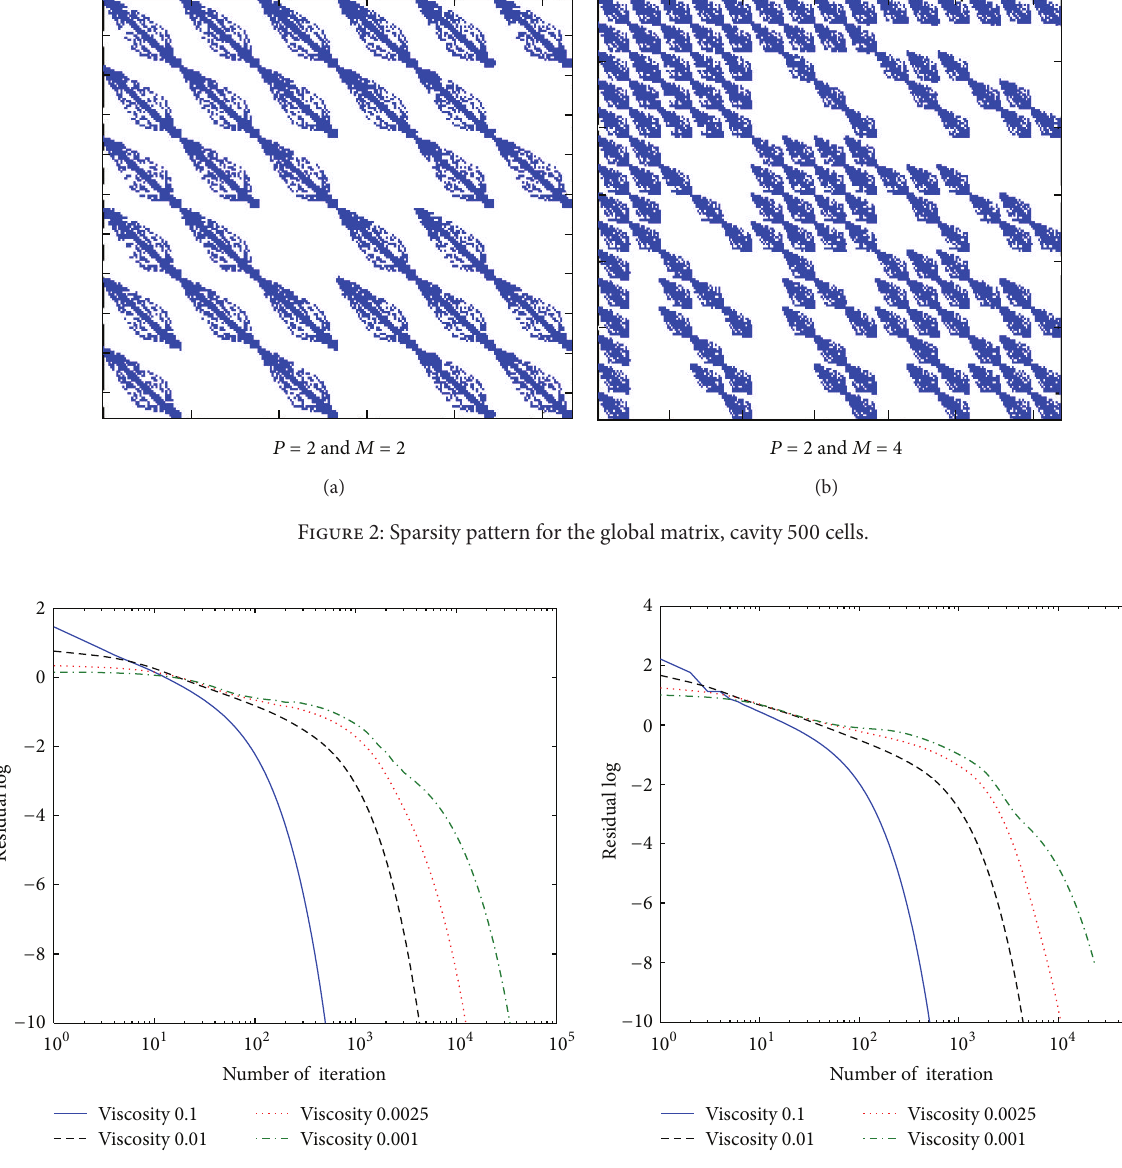
cost will be 𝑂(𝑁𝑀 𝑃 ) , where 𝑁 is the number of degrees of freedom (number of nonboundary nodes in our case) and 𝑃 and 𝑀 are the order and dimension,